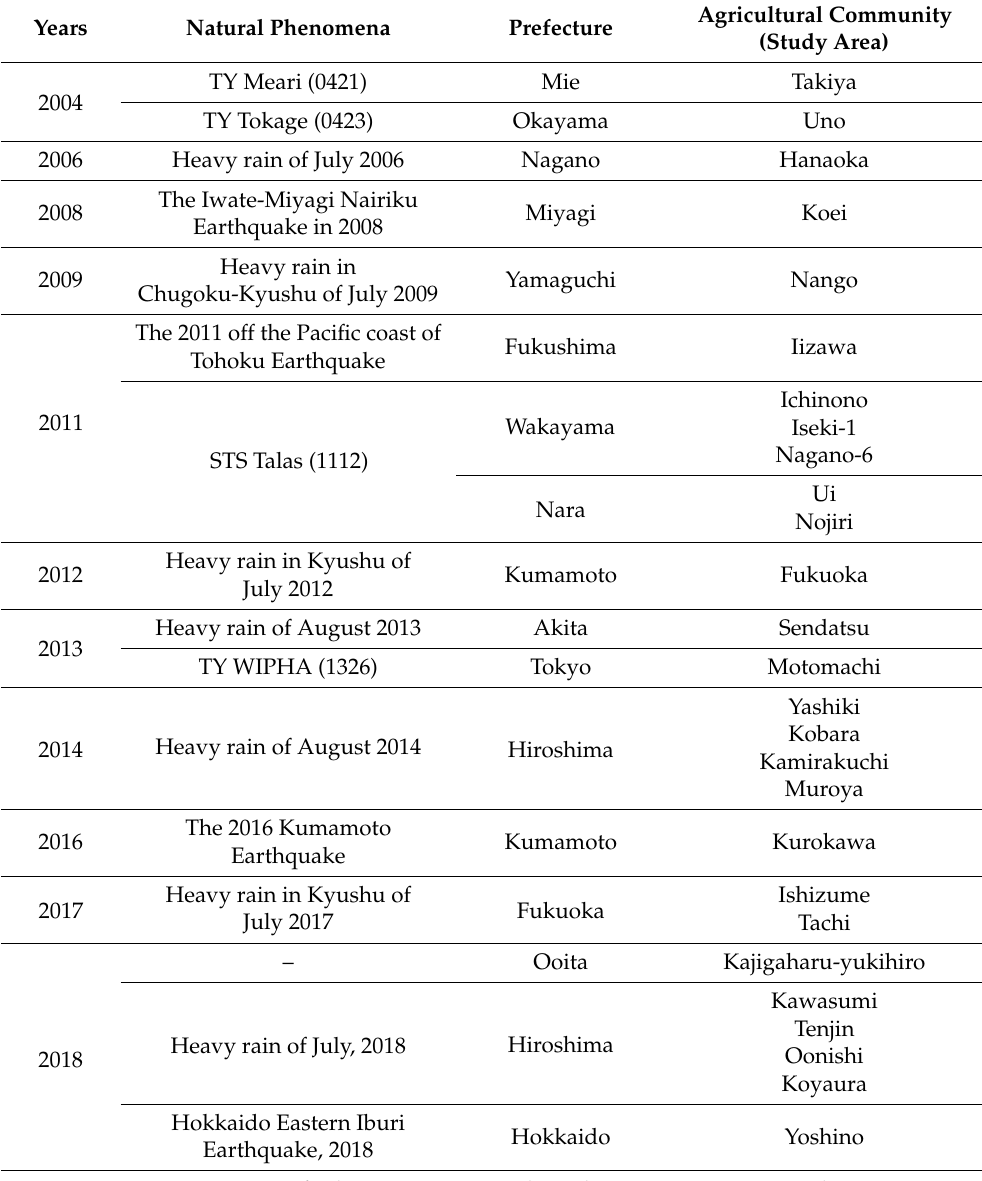
Table 1. Study areas where losses occurred between 2004 and